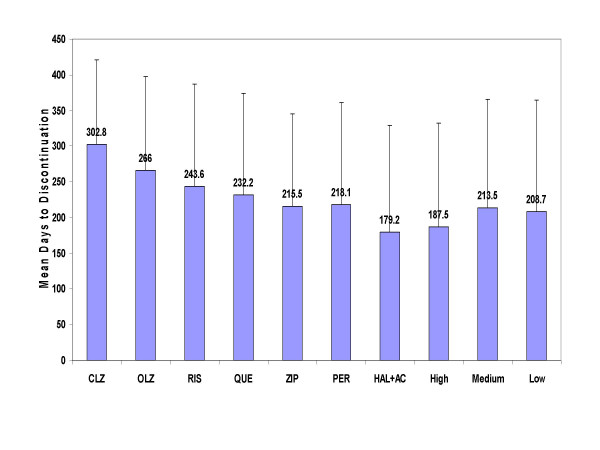
Mean time to all-cause medication discontinuation for atypical and typical antipsychotics. Abbreviations: CLZ, clozapine; OLZ, olanzapine; RIS, risperidone; QUE, quetiapine; ZIP, ziprasidone; PER, perphenazine; HAL+AC, haloperidol with prophylactic anticholinergic agents; High, high-potency typical antipsychotics; Med, medium-potency typical antipsychotics; Low, low-potency typical antipsychotics. Error bars represent standard deviations. Significant differences (p < .05) between high-potency typicals and CLZ, OLZ, RIS, QUE; between medium-potency typicals and CLZ, OLZ, RIS; between low-potency typicals and CLZ, OLZ, RIS; between perphenazine and CLZ, OLZ, RIS; and between haloperidol with prophylactic anticholinergics and CLZ, OLZ, and RIS. Comparisons made with Cox Proportional Hazards regression model adjusted for patients and prior treatment characteristics.